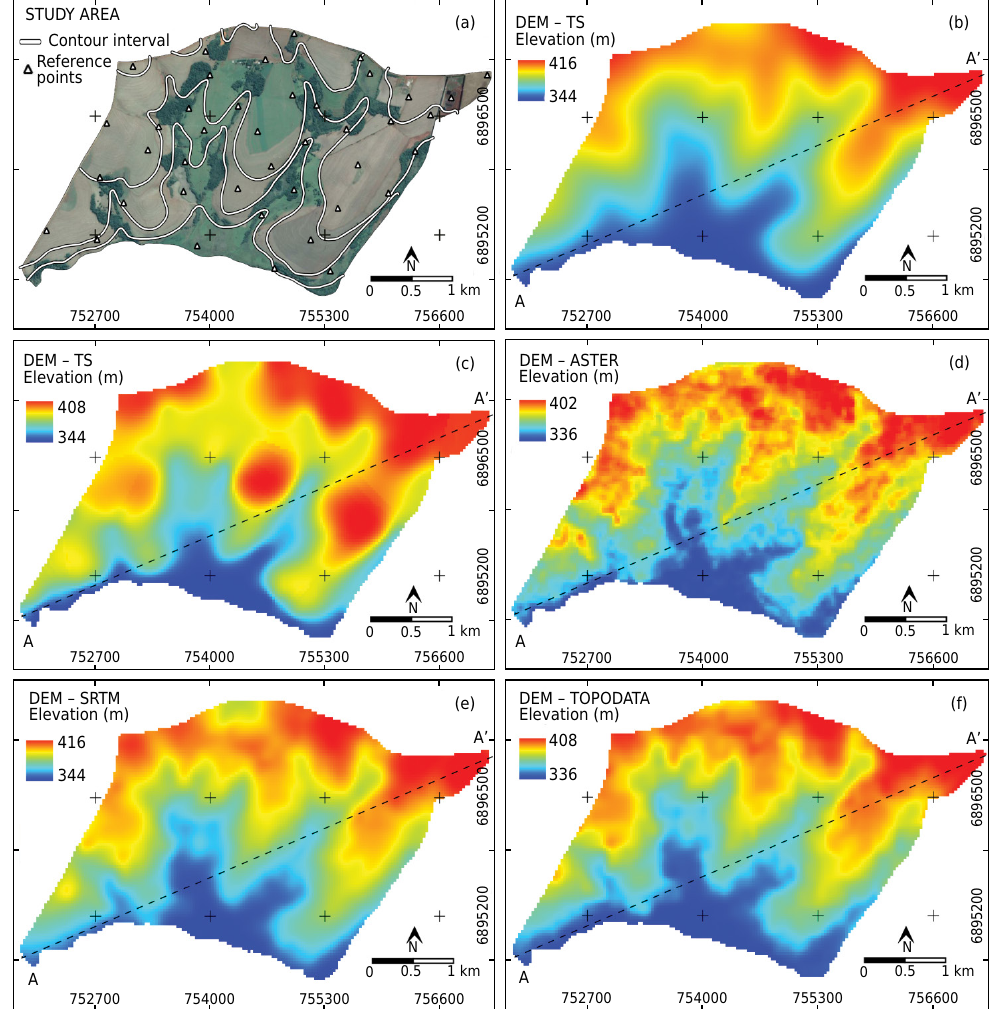
Figure 2. (a) Study area with the locations of 41 reference points (RP) and contour line (20 m) from the Topographic Map (TM); (b) DEM-TS; (c) DEM-TM; (d) DEM-ASTER; (e) DEM-SRTM; (f) DEM-TOPODATA; the dashed line represents the DEM transect